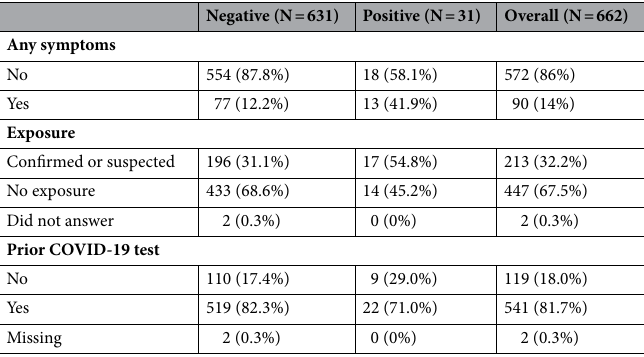
Table 2. Tester symptoms, exposure history and prior COVID-19 testing per each CareStart testing occurrence, including repeated tests from the same participants.